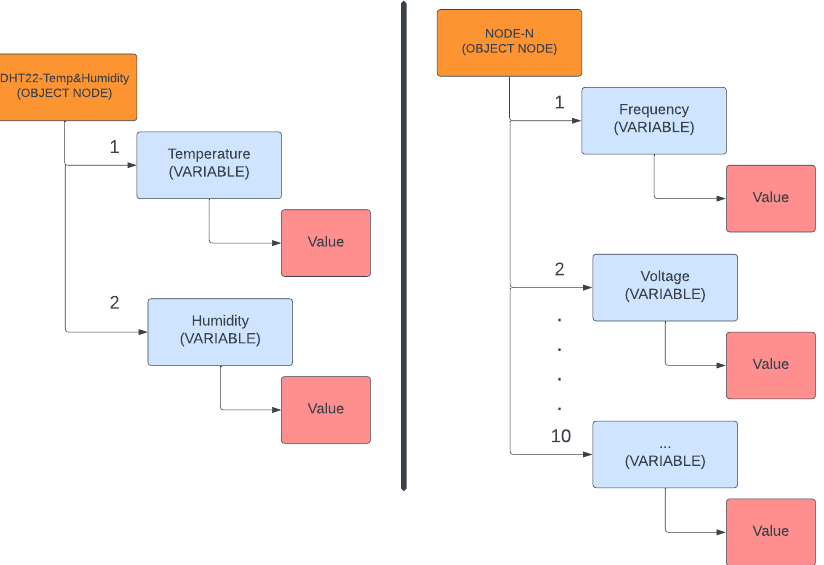
Figure 5. Data model of the Address